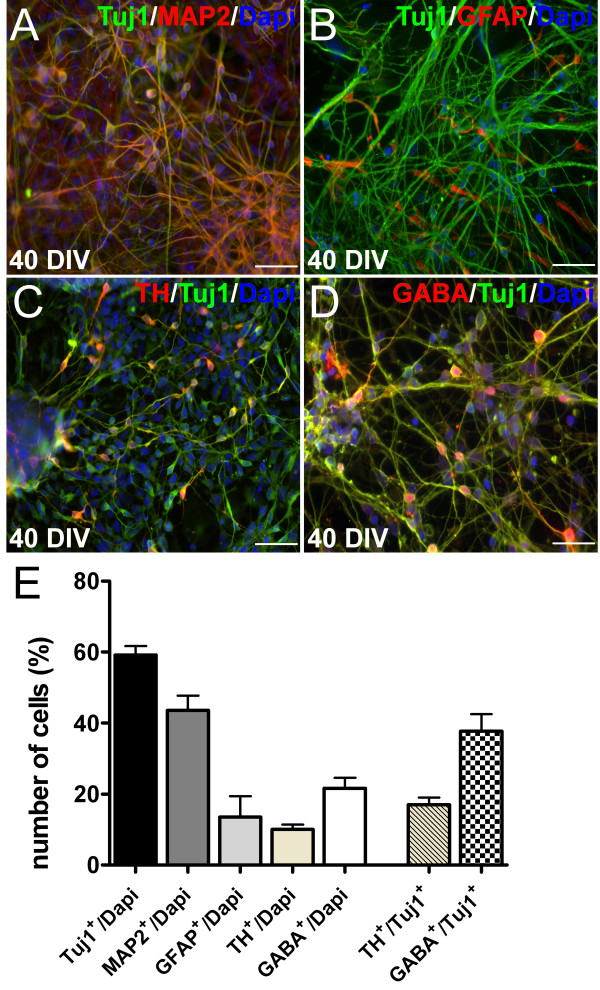
hCBiPSCs differentiated into dopaminergic and GABAergic neurons. (A, E) After 40 days of in vitro differentiation (40 DIV) almost 60% of the cells were positive for the neuronal marker beta III tubulin (Tuj1) and 40% showed reactivity against MAP2 indicating more mature neurons. A minor cell population of roughly 13% was positive for the astrocytic marker GFAP (B, E). Approximately 17% of Tuj1-positive cells were double labeled with antibodies against the dopaminergic marker tyrosine hydroxylase (TH, C, E) and nearly 40% were immunopositive for GABA (D, E). Scale bars represent 50 μm. Values are calculated as means ± SEM. hCBiPSC, human cord blood induced pluripotent stem cells; SEM, standard error of the mean.